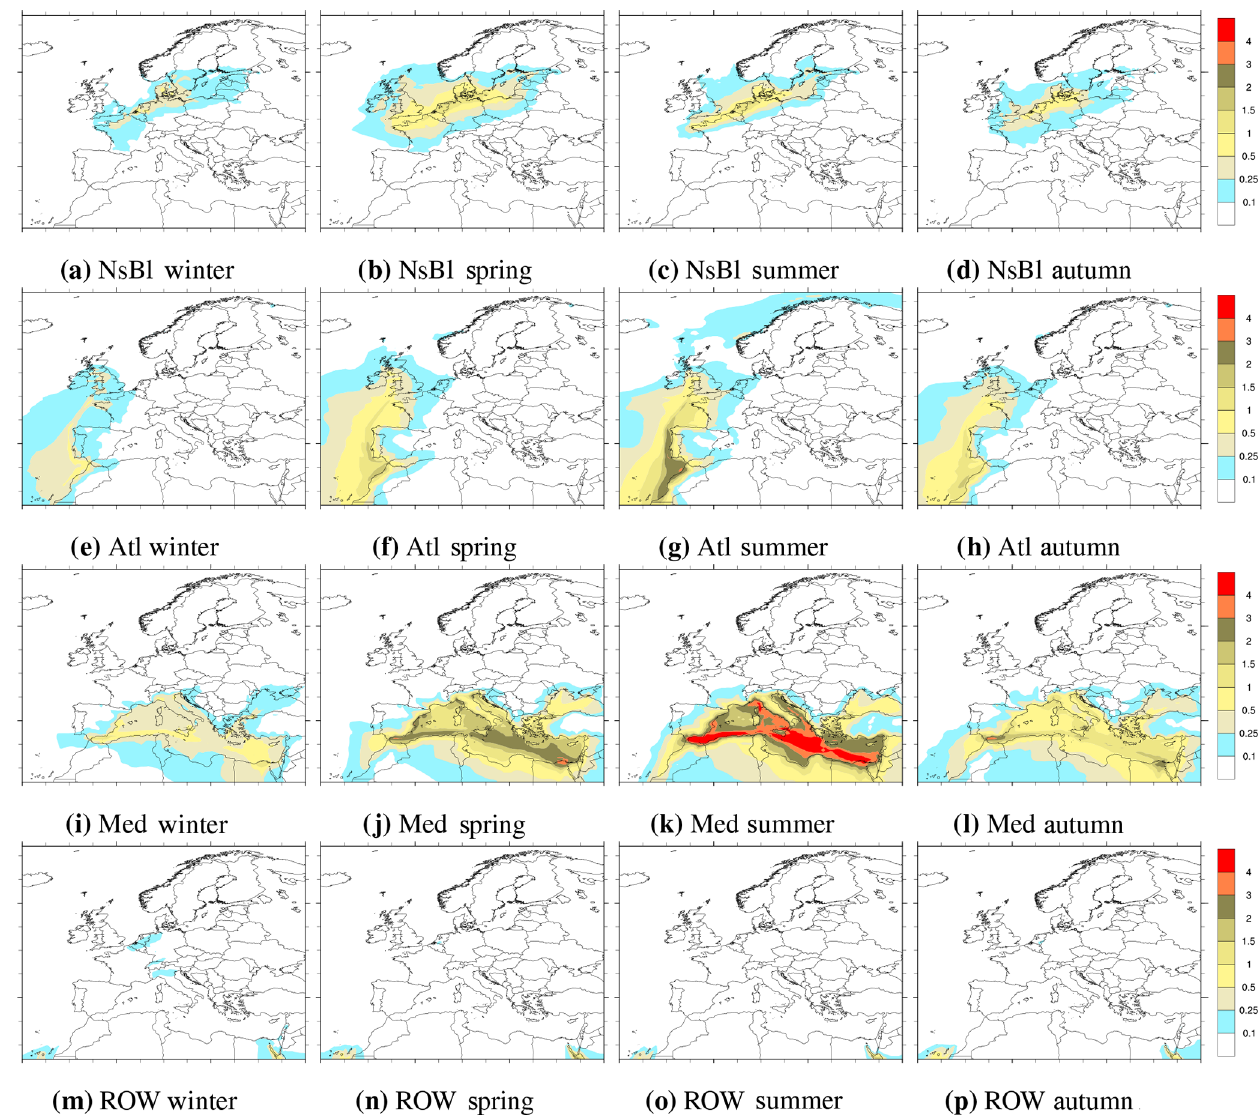
Figure 3. Seasonal contributions to European PM 2 . 5 levels (in µgm − 3 ) from 15% perturbations of the emissions in separate sea areas defined in Sect. 2.3. Winter is defined as December–January, spring March–May, summer June–August, and autumn September–November. The contributions from shipping have been multiplied by 100 /